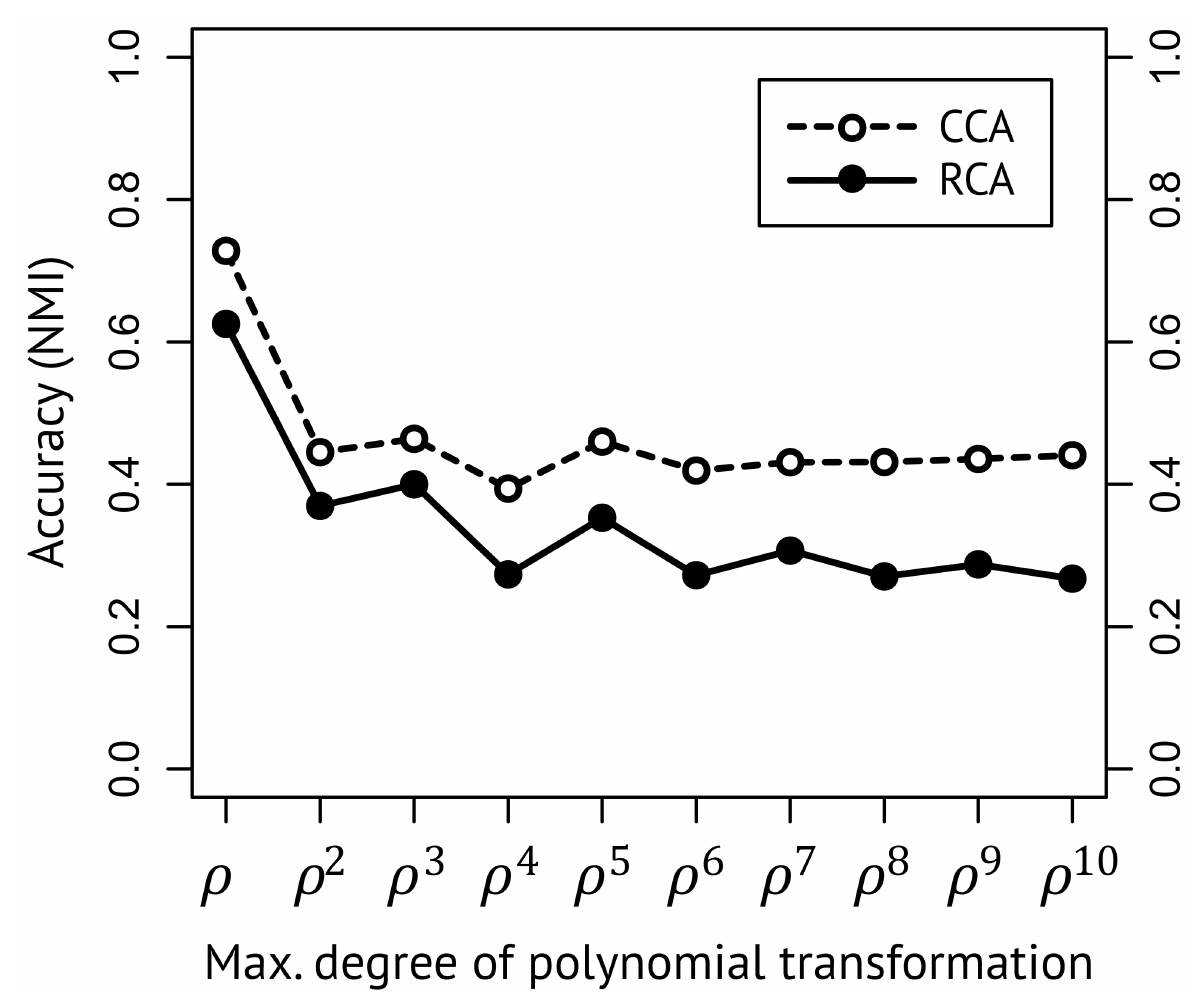
Figure 7: Accuracy for 3,000 simulations with polynomial functional